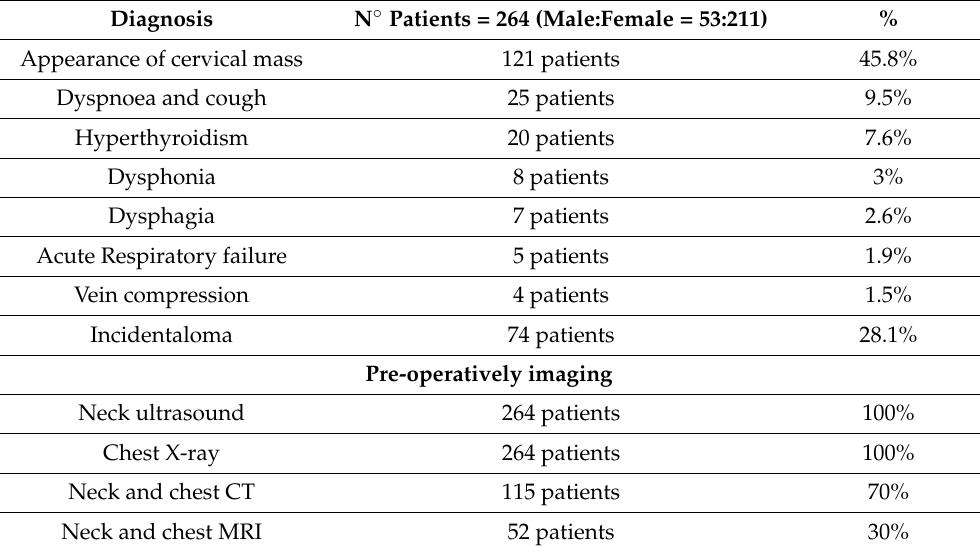
Table 1. General data of patients included in the study.